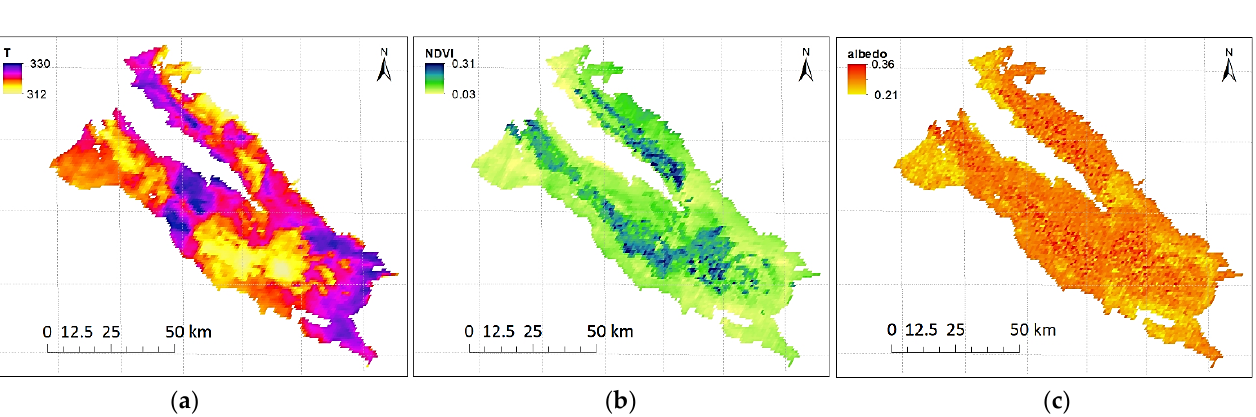
Figure 3. MODIS ( a ) land surface temperature, ( b ) NDVI, and ( c ) Albedo products of Rafsanjan Plain for random days during the study period.